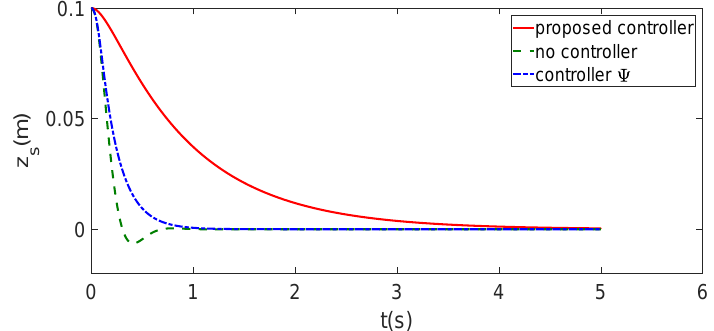
Figure 3. Vehicle body vertical